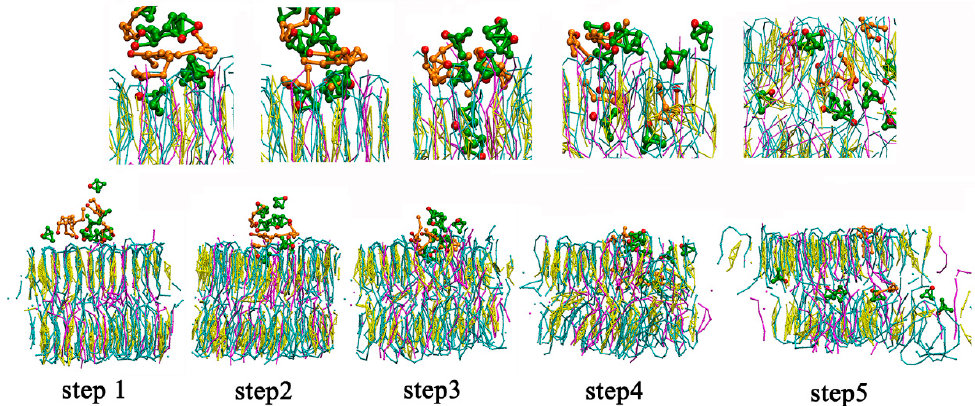
Figure 6. Permeation process of osthole molecules with “pull” effect of borneol during the first 100 ns of 5% borneol and 10% osthole system by CG-MD simulations.